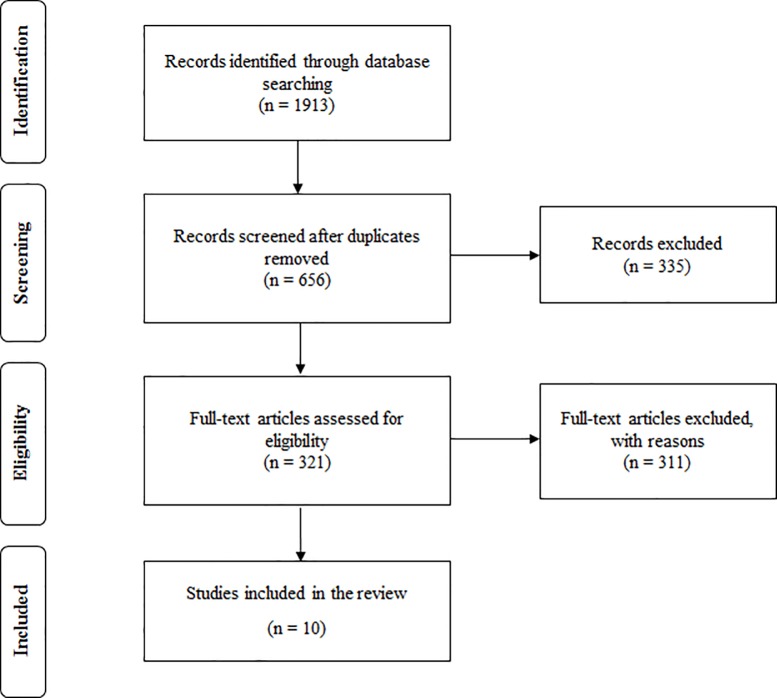
Flowchart of the search strategy and selection of articles.